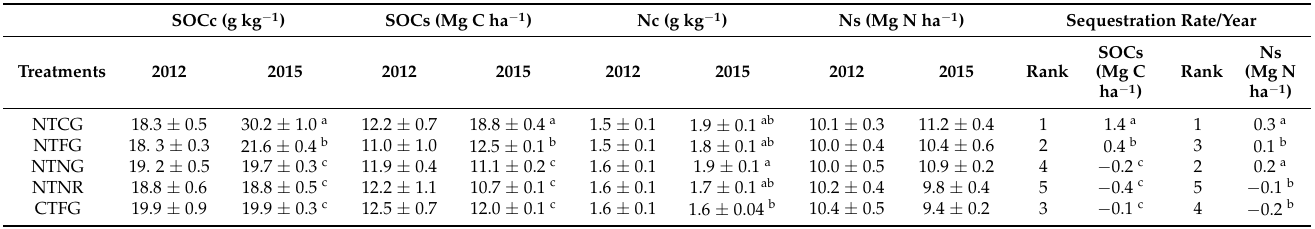
Table 3. Mean ± SE of soil organic carbon content and stocks (SOCc and SOCs) and soil nitrogen content and stocks (Nc and Ns) at topsoil (0–0.05 m) under conventional tillage with free grazing (CTFG), no-tillage with free grazing (NTFG), no-tillage with no grazing (NTNG), no-tillage without crop residue mulching (NTNR) and no-tillage with controlled grazing (NTCG) before (January 2012) and after three years of the treatments’ implementation (May 2015). N = 9.